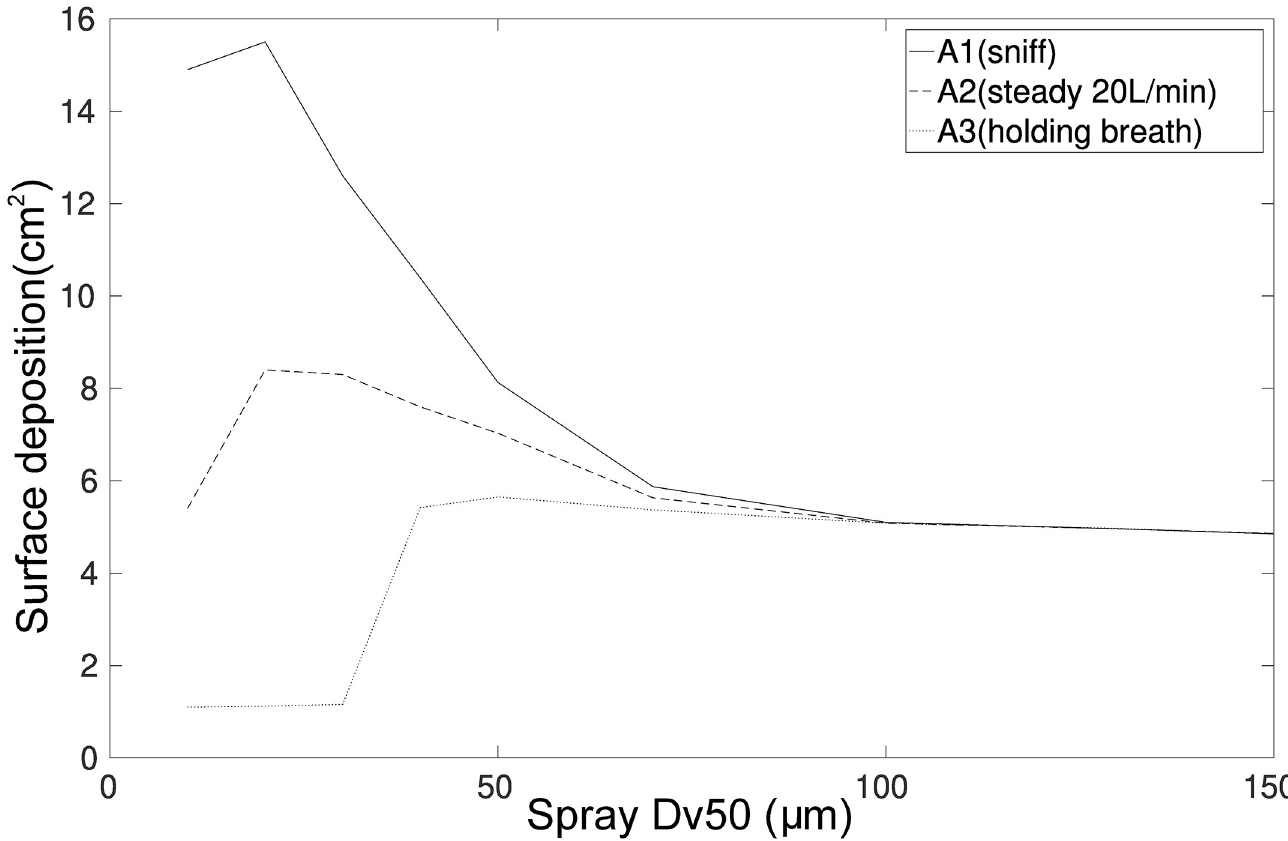
Fig 16. Surface deposition observed in the middle section, see Fig 16, for the three inhalation conditions.